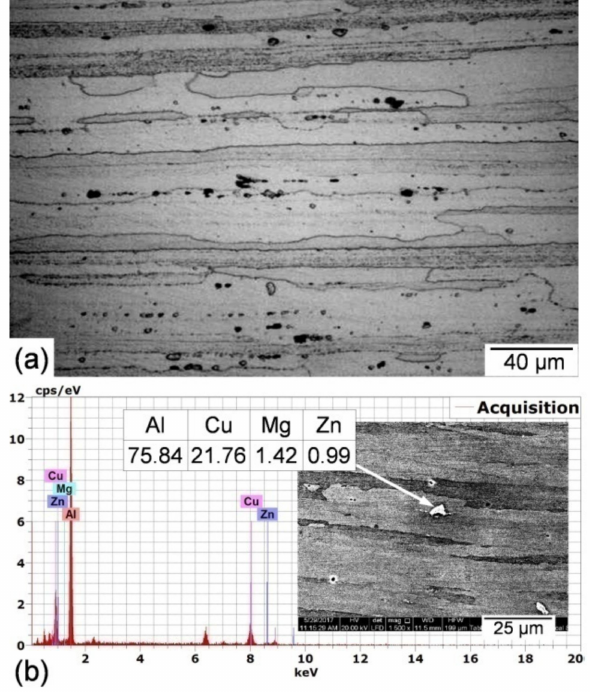
Figure 5. Optical microscopic photograph ( a ) and EDS microanalysis of the strengthening precipitates ( b ) of the base